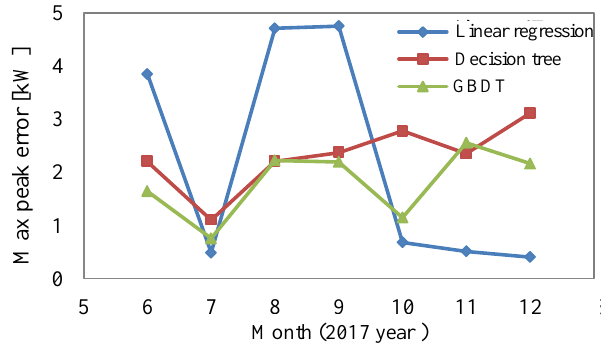
Figure 11. Transition of peak error for each method per month.